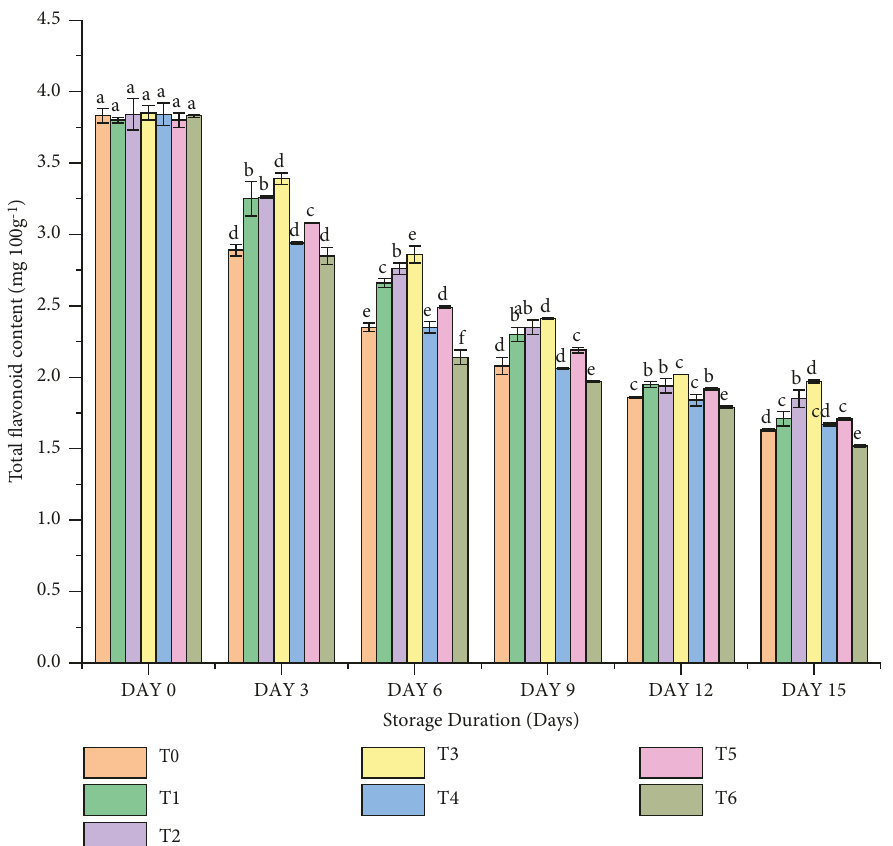
Figure 9: Effect of chitosan coating and cinnamon essential oil on total flavonoid content of pomegranate arils during storage at 4 ± 1 ° C. Vertical bars represent the mean ± SD of 3 replicates. Error bars with different letters on the same storage period show a significant difference ( P ≤ 0 . 05). T0 � control; T1 � 1% chitosan+0.25% oil; T2 � 1% chitosan+0.5% oil; T3 � 2% chitosan+0.25% oil; T4 � 2% chitosan+0.5% oil; T5 � 3% chitosan+ 0.25% oil; T6 � 3% chitosan+0.5%